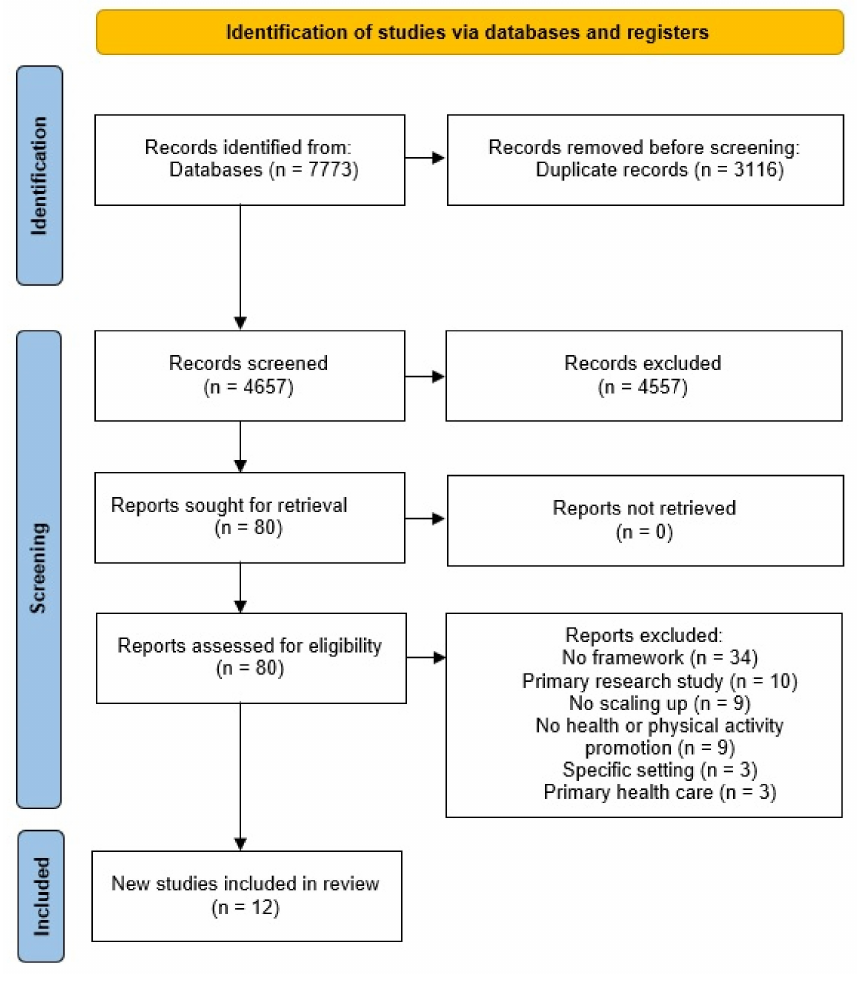
Figure 1. PRISMA flow diagram of the BeHEMoTh search for frameworks. Table 1. Characteristics of the identified